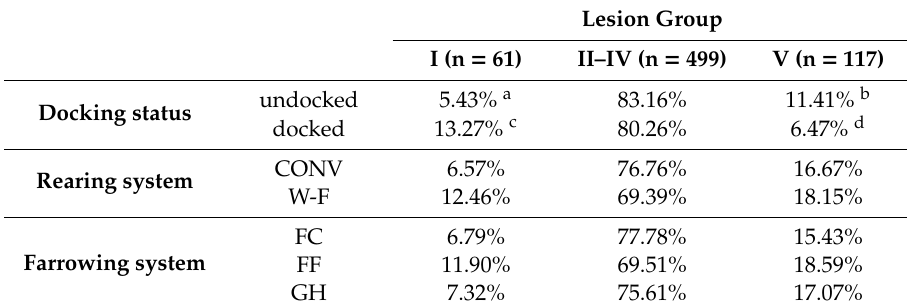
Table 3. Distribution of the characteristics of the pigs within the lesion groups I and V, related to all pigs of the specific group (Figure 1). Note that the significant di ff erences were calculated with absolute numbers of